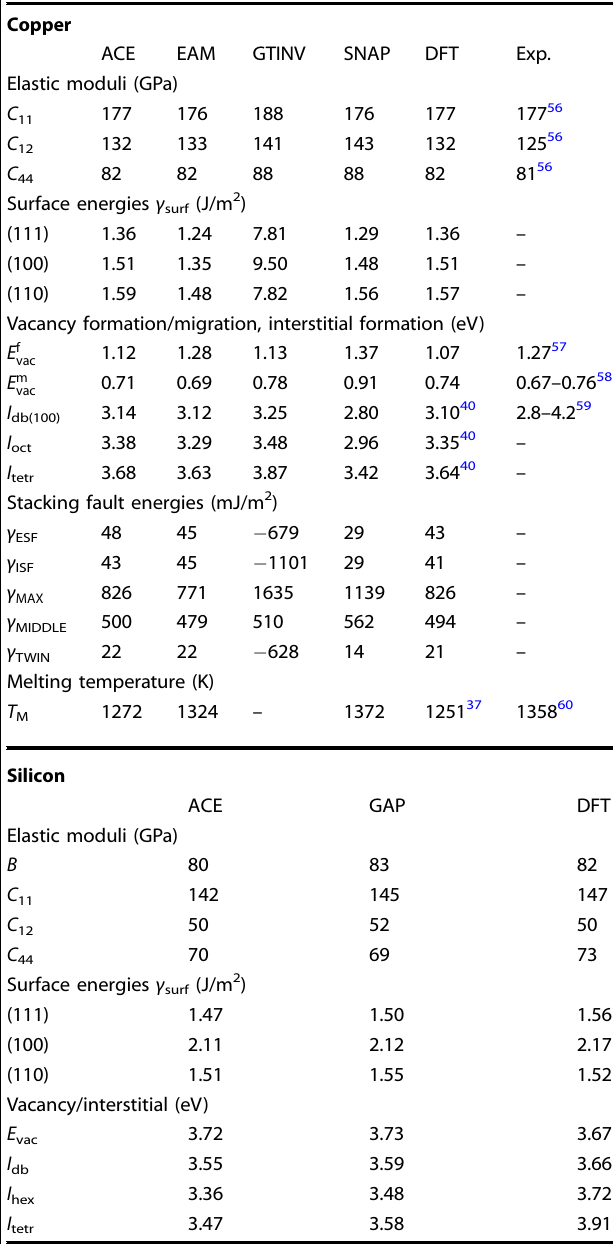
Transformations between different crystal structures present a sensitive test for any interatomic potential as both bond distances and bond angles are changed simultaneously. In addition, the associated changes in atomic coordination effectively scrutinize the screening of pairwise terms by many-atom contributions. As shown in Fig. 3, all potentials agree well with the reference DFT data for the tetragonal, trigonal, and hexagonal paths. However, only ACE provides an excellent quantitative interpolation for all structures along all considered transformation paths. Especially, the orthorhombic transformation, which can be regarded as a generalization of the Bain path 36 , is challenging for the other potentials.